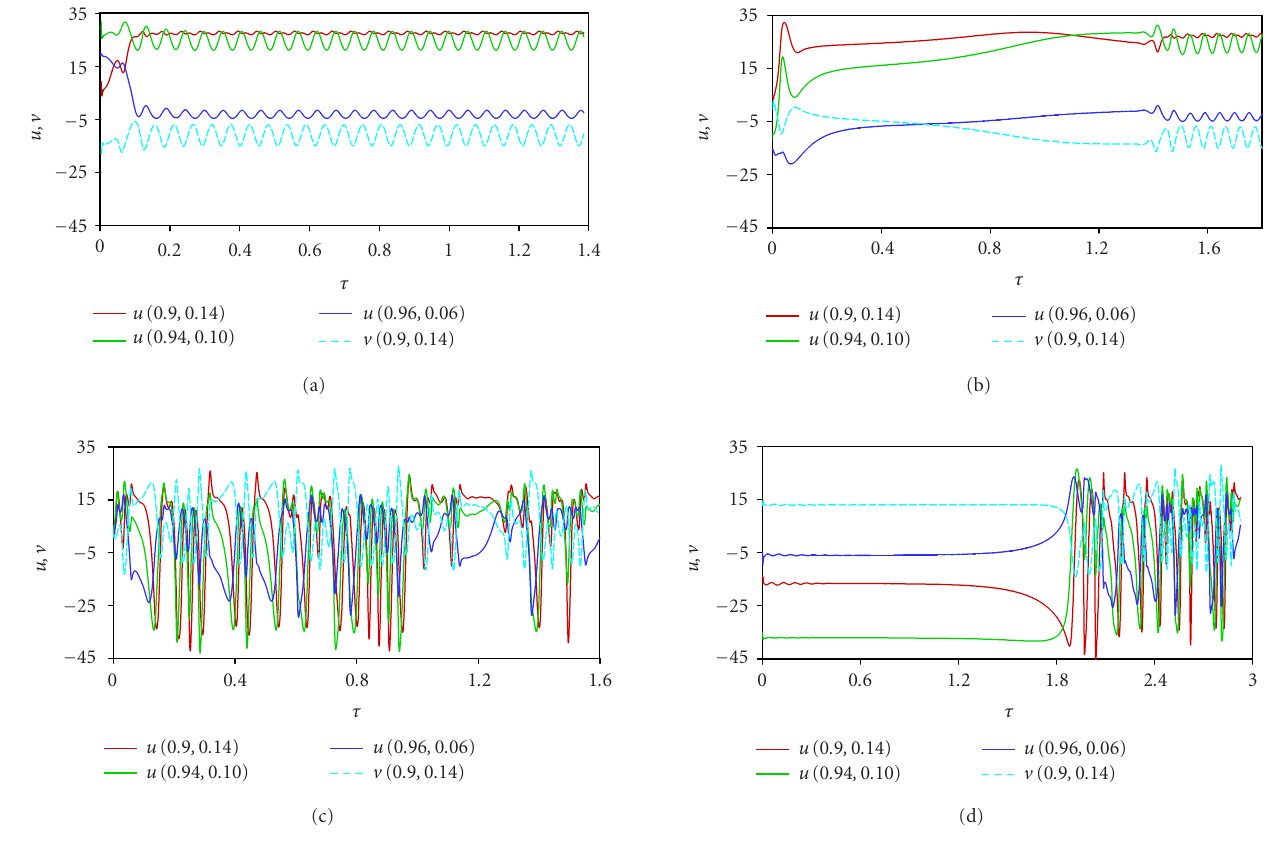
Figure 8: Dynamic response of four solutions at L 2 = − 11 . 7 to finite random disturbance: coexistence of periodic and chaotic oscillations ( σ = 0 . 02, Pr = 0 . 7, Dk = 300, and L 1 = 28). (a) Solution b shown in Figure 4b, (b) solution c shown in Figure 4c, (c) solution d shown in Figure 4d, and (d) solution e shown in Figure 4e.